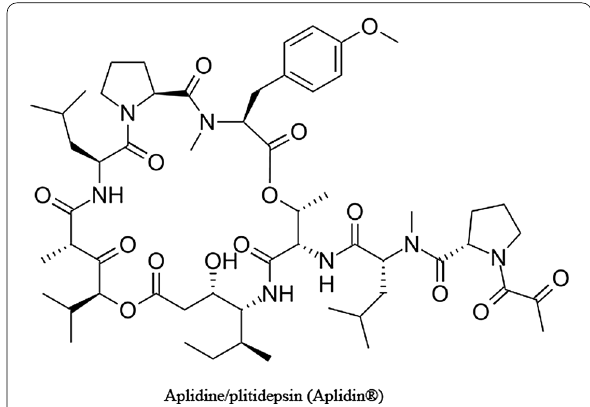
Fig. 3 Chemical structure of an Mediterranean marine tunicate Aplidium albicans derived Aplidine/plitidepsin (Aplidin ® )